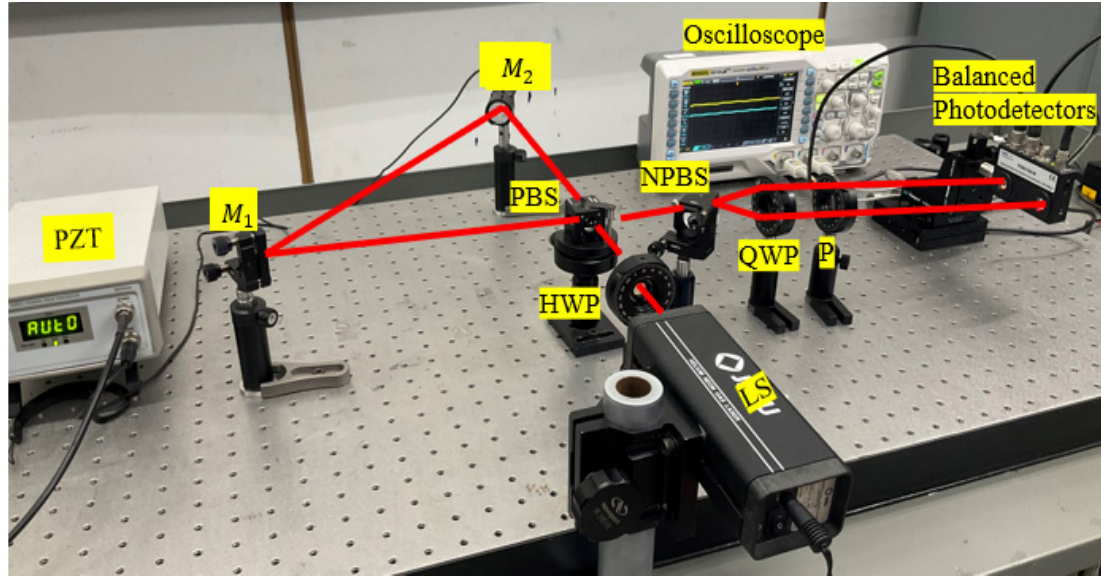
Figure 2. The experimental setup of the proposed modified Sagnac interferometer.